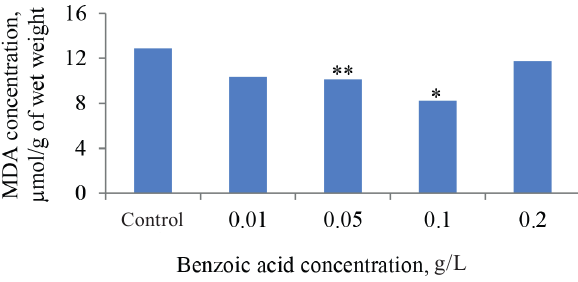
Figure 4 Effects of different doses of benzoic acid on